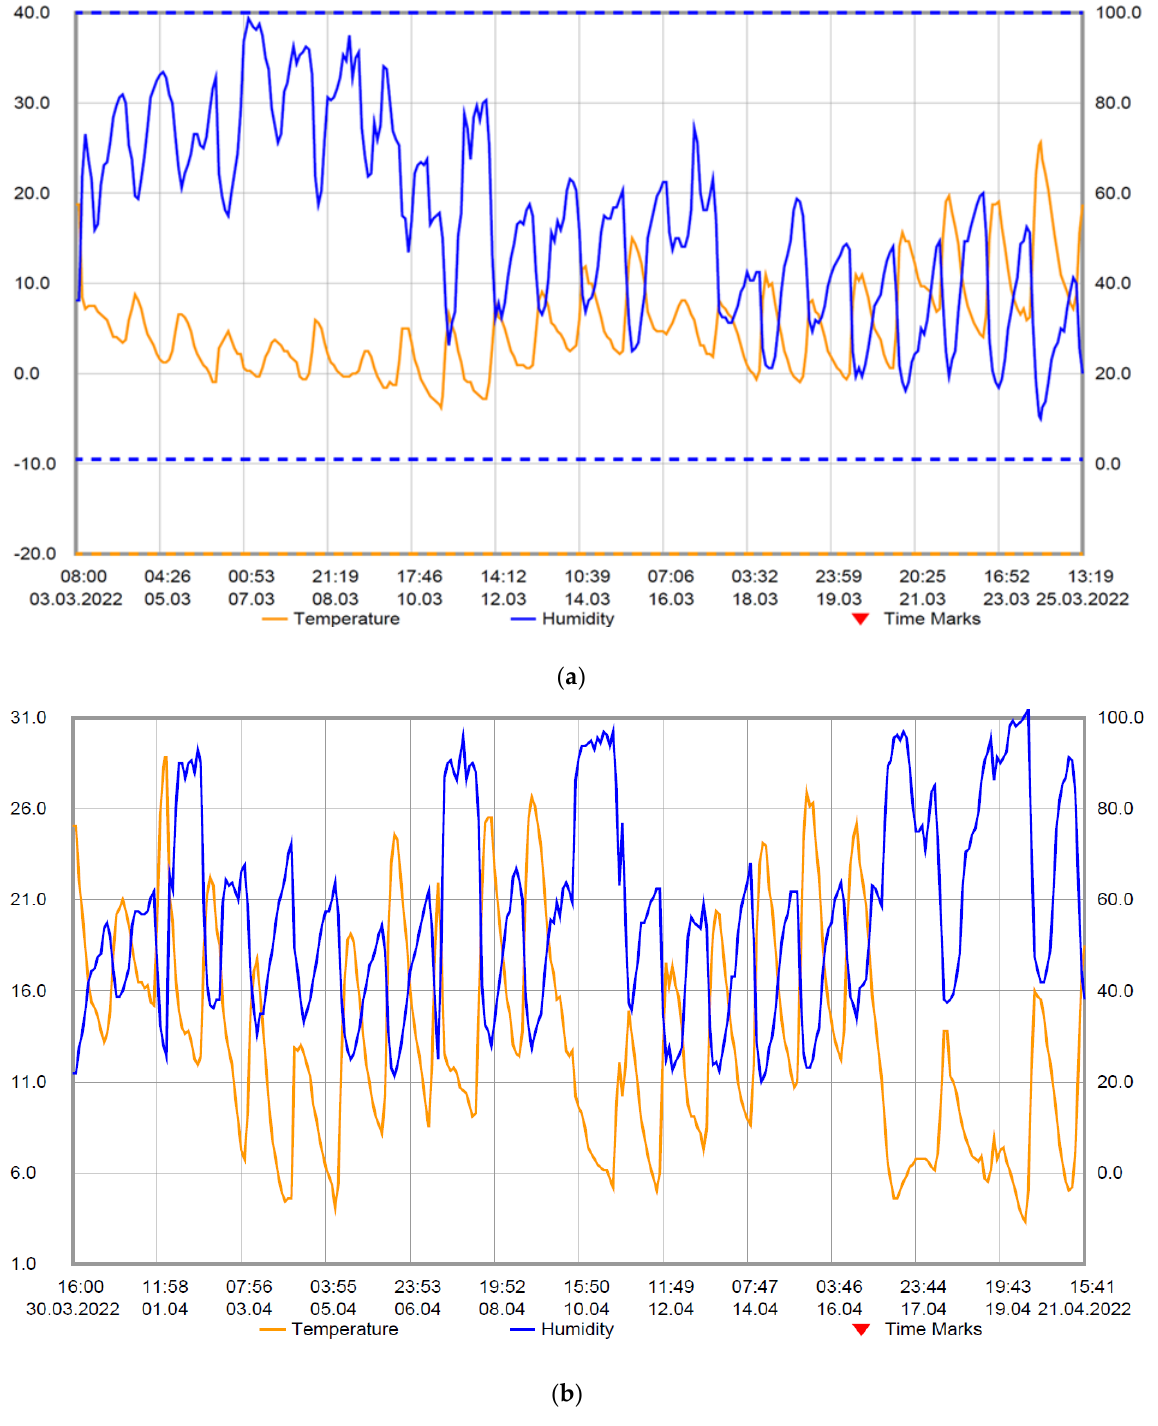
Figure 9. ( a ) Outdoor temperature between 7 March 2022 and 25 March 2022. ( b ) Outdoor temperature between 4 April 2022 and 21 April 2022.